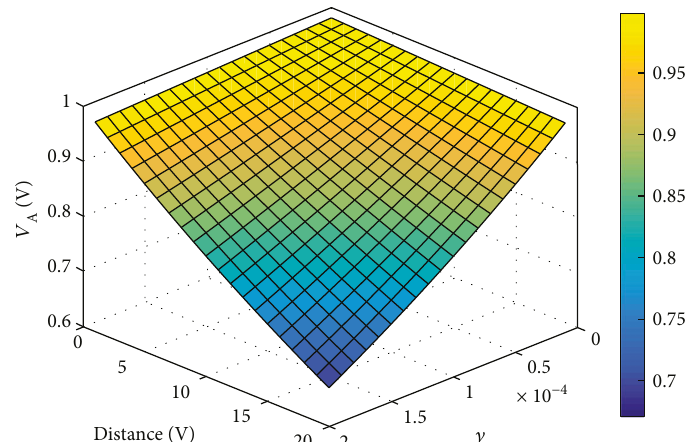
D , and parameter γ in the attractive A , distance between two individuals